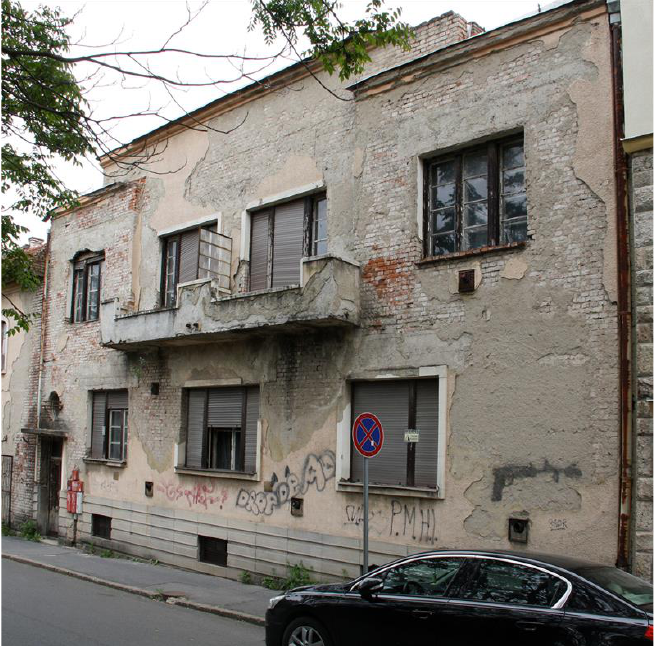
Figure 8. 5 Gusztáv Csengey street. Architect: Victor Bohm, 1931. Source: Lovra 2021. Figure 8. 5 Guszt á v Csengey street. Architect: Victor Bohm, 1931. Source: Lovra